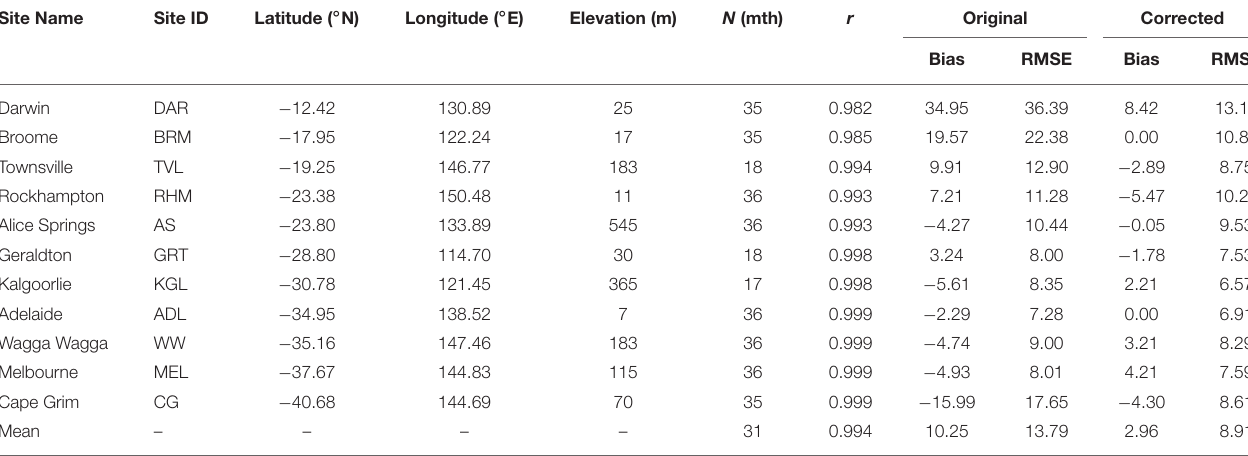
TABLE 2 | Bias and RMSE of the AHI-based monthly mean solar flux ( F c ) when compared to surface-level solar flux measurements ( F m ).